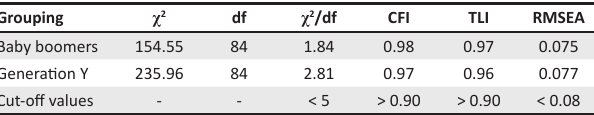
TABLE 1: Confirmatory factor analysis fit statistics for individual measurement models based on the cohorts. Grouping